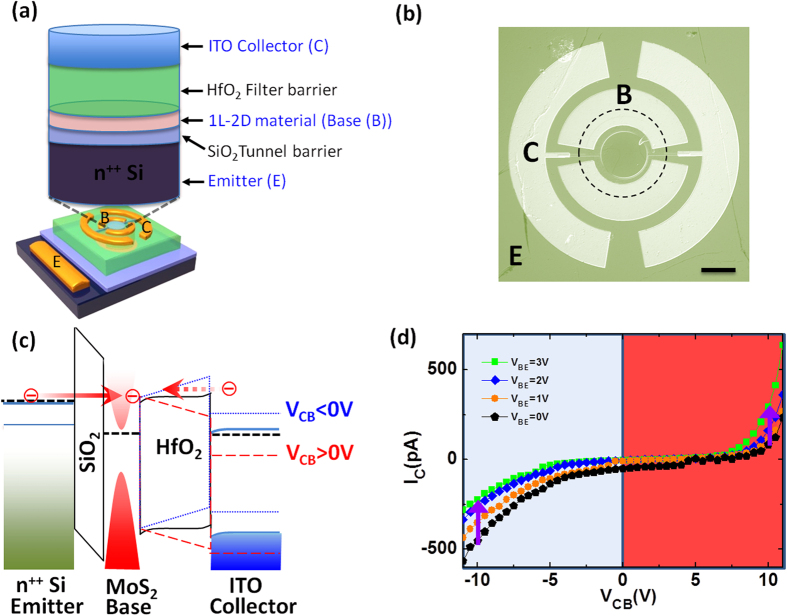
Device structure and energy band diagram of the MoS2-HET.(a) An isometric view of an MoS2-HET device structure. The capital letters E, B, and C represent the emitter, base, and collector, respectively. (b) Optical micrograph (top-view) of an actual MoS2-HET device. The scale bar is 100 μm. The dashed circle outlines the MoS2 region. (c) Energy band diagram depicting the collector current contributions at the on-state condition for two different polarities of the collector-base voltage. For VCB > 0 (dashed red lines), the hot-electrons tunneling through the emitter-base tunnel barrier have sufficient kinetic energy to overcome the filter barrier and reach the collector, whereas for VCB < 0 (dotted blue lines), electrons flow from the ITO to the base region to form a reverse base-collector current. (d) Common-base output characteristics. The collector current is shown as a function of VCB at VBE = 0 V, +1 V, +2 V, and +3 V.